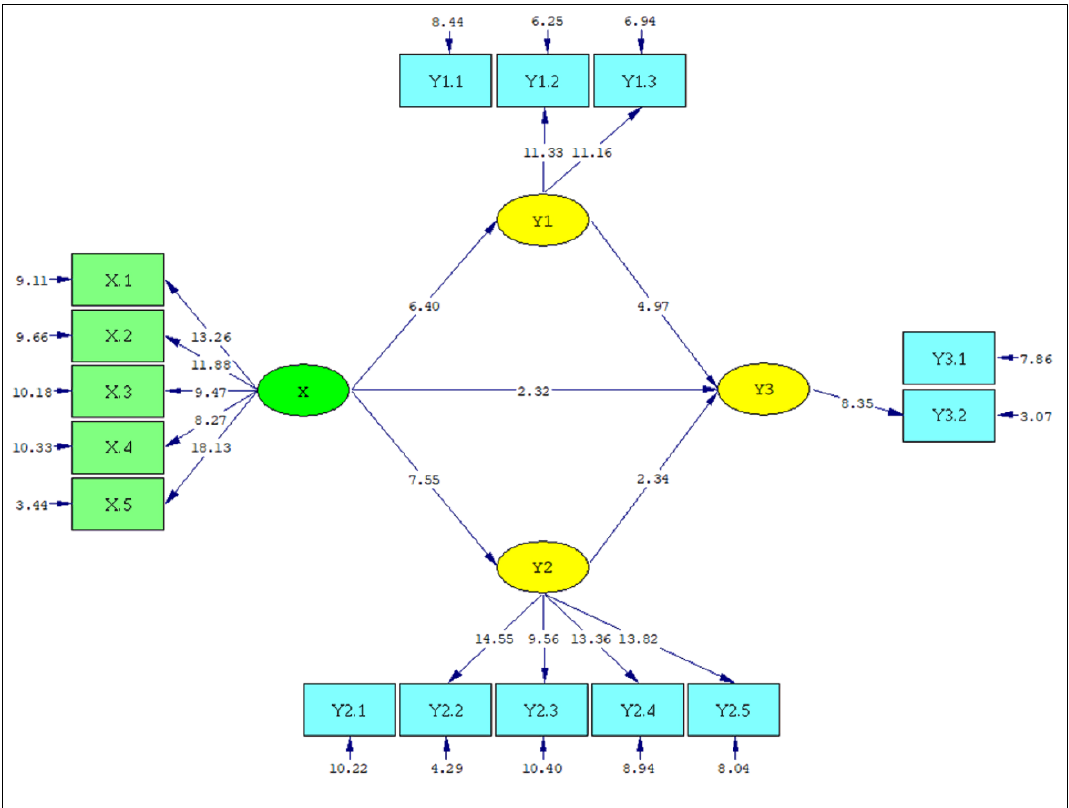
Figure 3. T value structural model